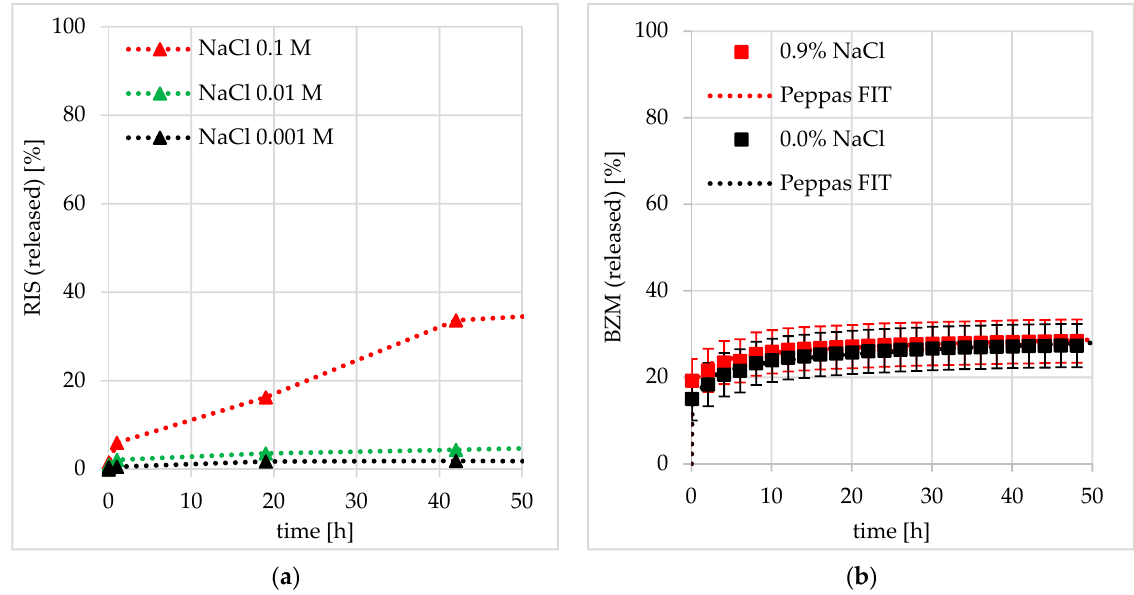
Figure 17. Drug release kinetics from cationic PEC 0.7 @ Ti40Nb in dependence of NaCl concentration in the release medium for ( a ) negatively charged risedronate (RIS) and ( b ) uncharged BZM.